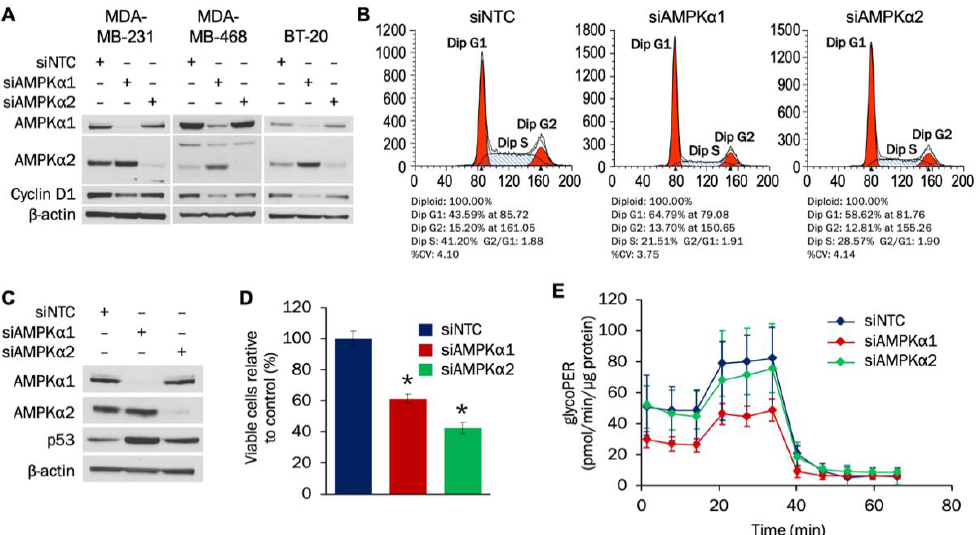
Figure 2. AMPKα1 and AMPKα2 impact proliferation and cell cycle progression in TNBC cells. ( A ) Figure 2. AMPK α 1 and AMPK α 2 impact proliferation and cell cycle progression in TNBC